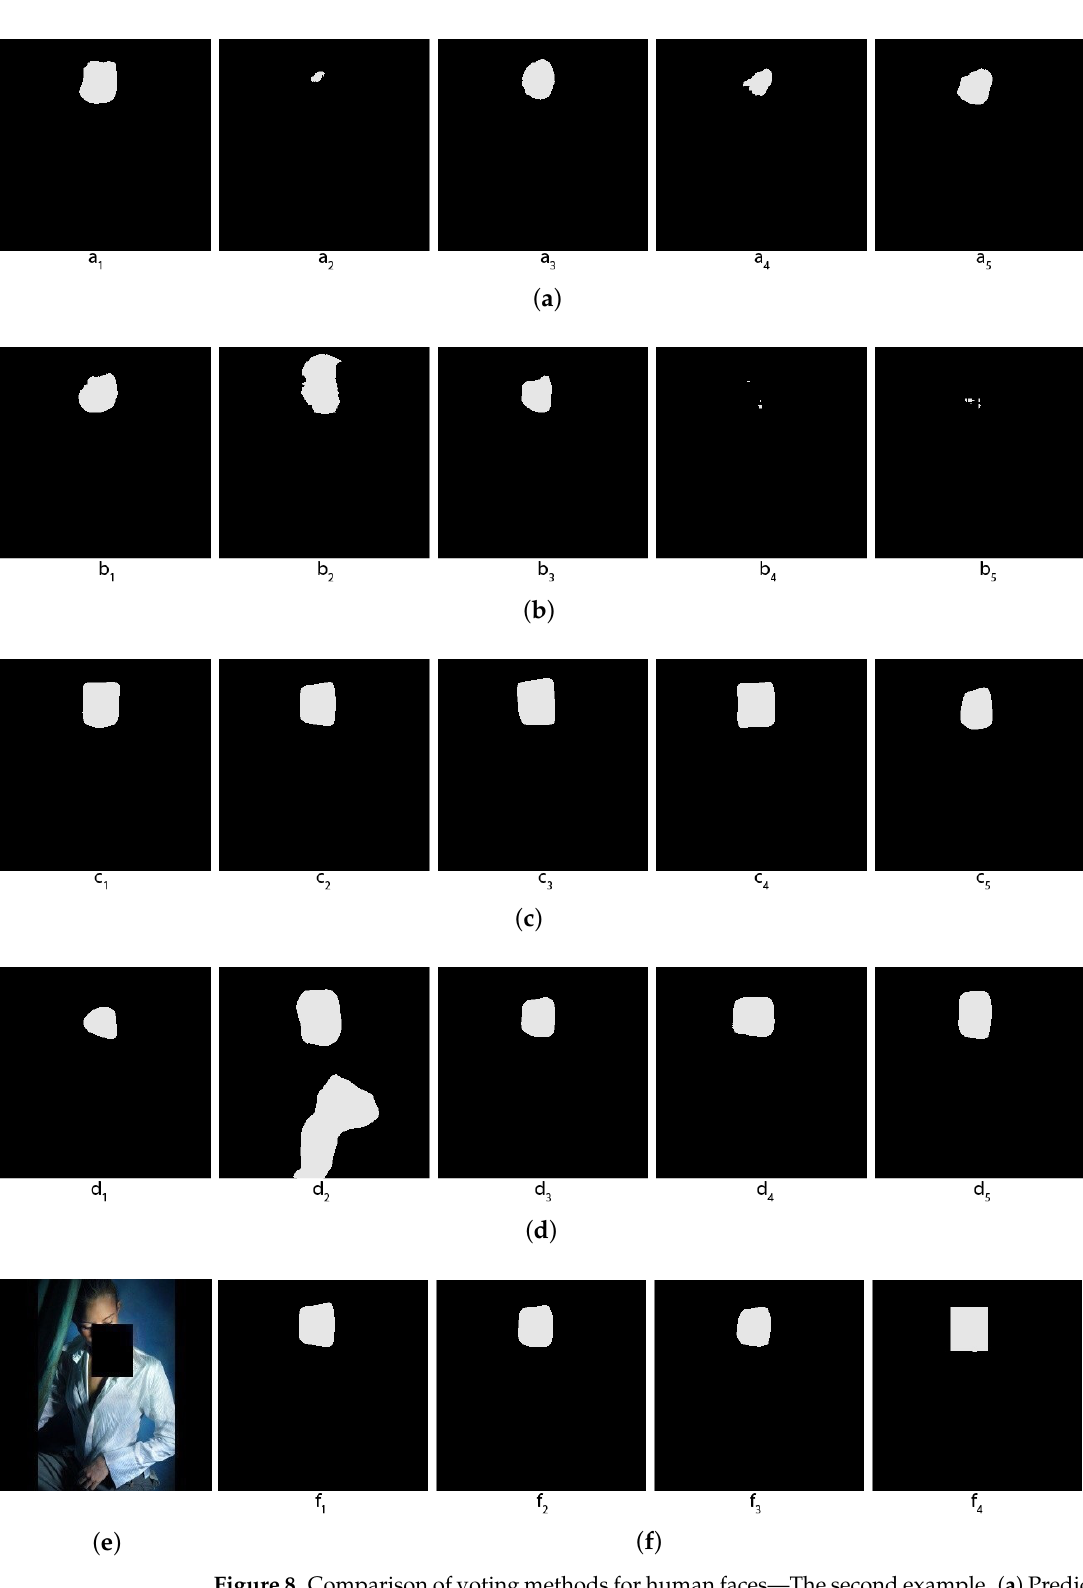
Figure 8. Comparison of voting methods for human faces—The second example. ( a ) Predictions of the first 5 folds (with Mobilenet); ( b ) Predictions of the last 5 folds (with Mobilenet); ( c ) Predictions of the first 5 folds (with EfficienNet); ( d ) Predictions of the last 5 folds (with EfficienNet); ( e ) Original image; ( f ) f 1 : Topological voting, f 2 : Hybrid voting (threshold = 2), f 3 : Arithmetical voting, f 4 : True Mask.